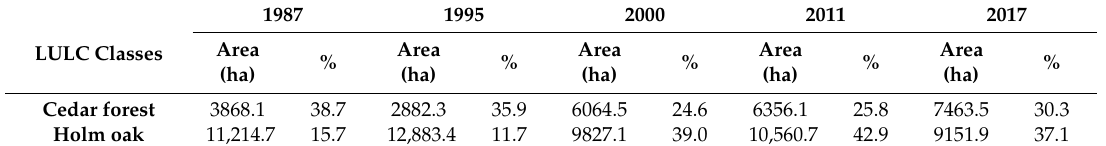
Table 4. Land-cover (in hectare and percentage) from 1987 to 2017.